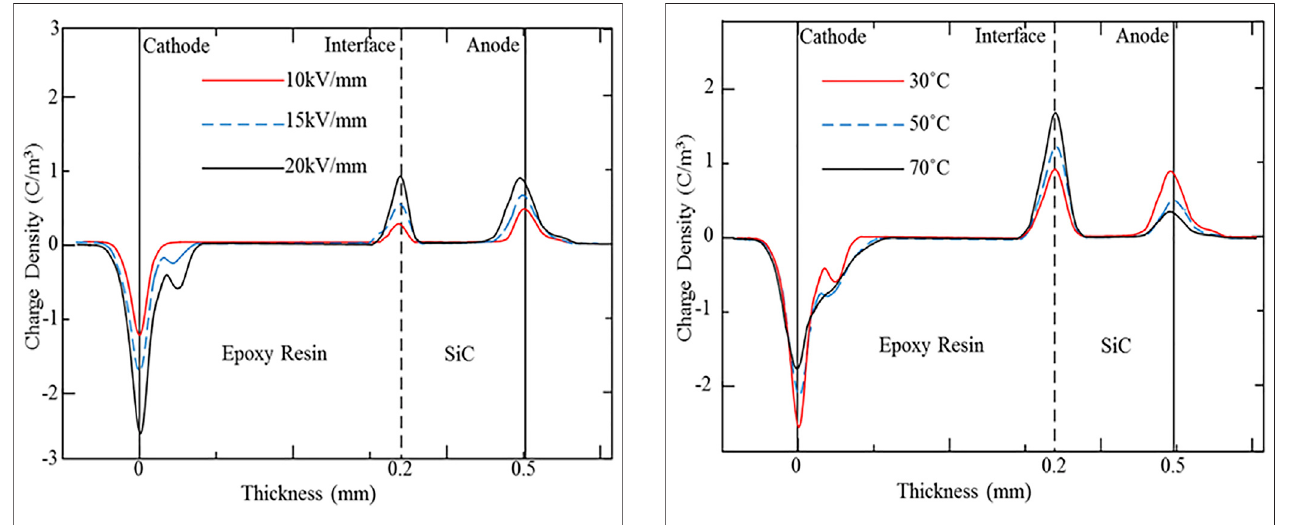
FIGURE 5 | Space charge pro fi les for the SiC – epoxy resin double- layered sample under different temperature conditions.